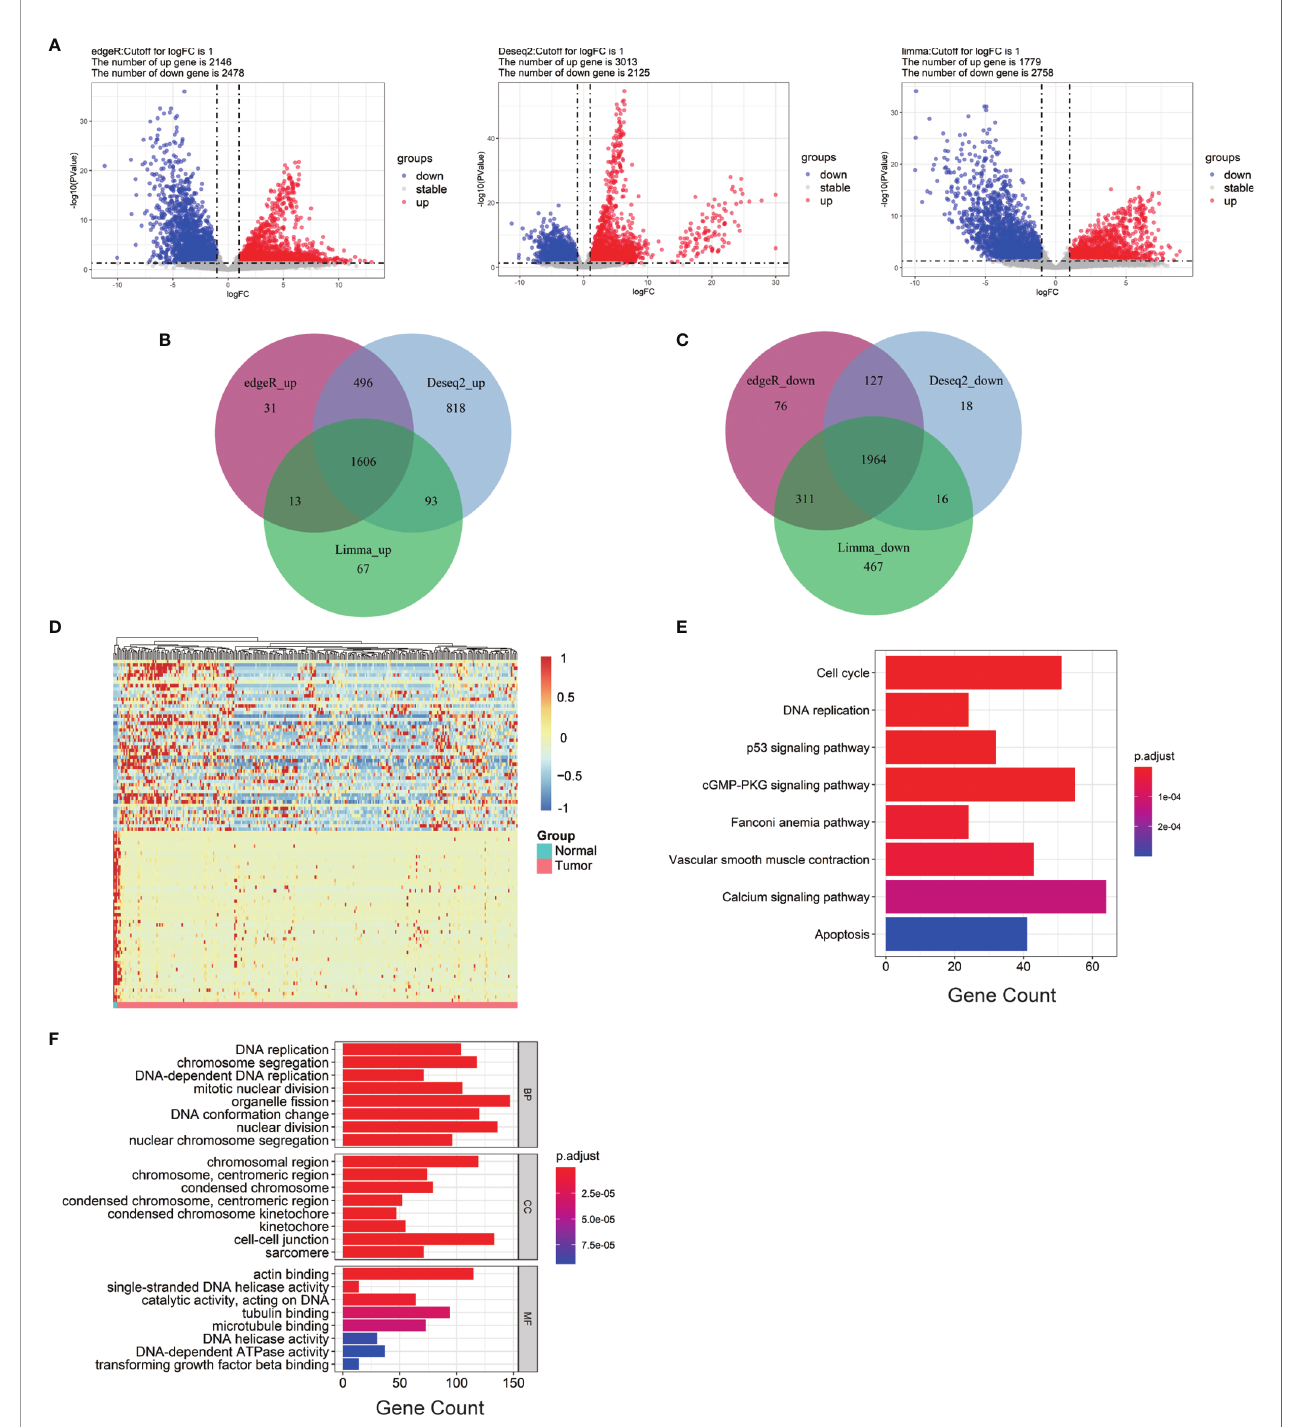
FIGURE 1 | Bioinformatics analysis of all DEGs from cervical cancer tissue samples. (A) Volcano plots of DEGs screened by three methods. “ Down ” refers to the genes that were downregulated. “ Up ” refers to the genes that were upregulated. “ Stable ” refers to the genes that have no difference in expression between tumor groups and normal groups. (B) Upregulated genes. (C) Downregulated genes. (D) The heatmap of the top 200 DEGs according to the value of |logFC|. (E, F) KEGG pathway enrichment and GO enrichment of DEGs. Each column bar on the y-axis represents an enrichment pathway, and the x-axis is the number of genes that were enriched in this pathway. DEGs, differentially expressed genes; logFC, log fold change; BP, biological process; CC, cellular component; MF, molecular